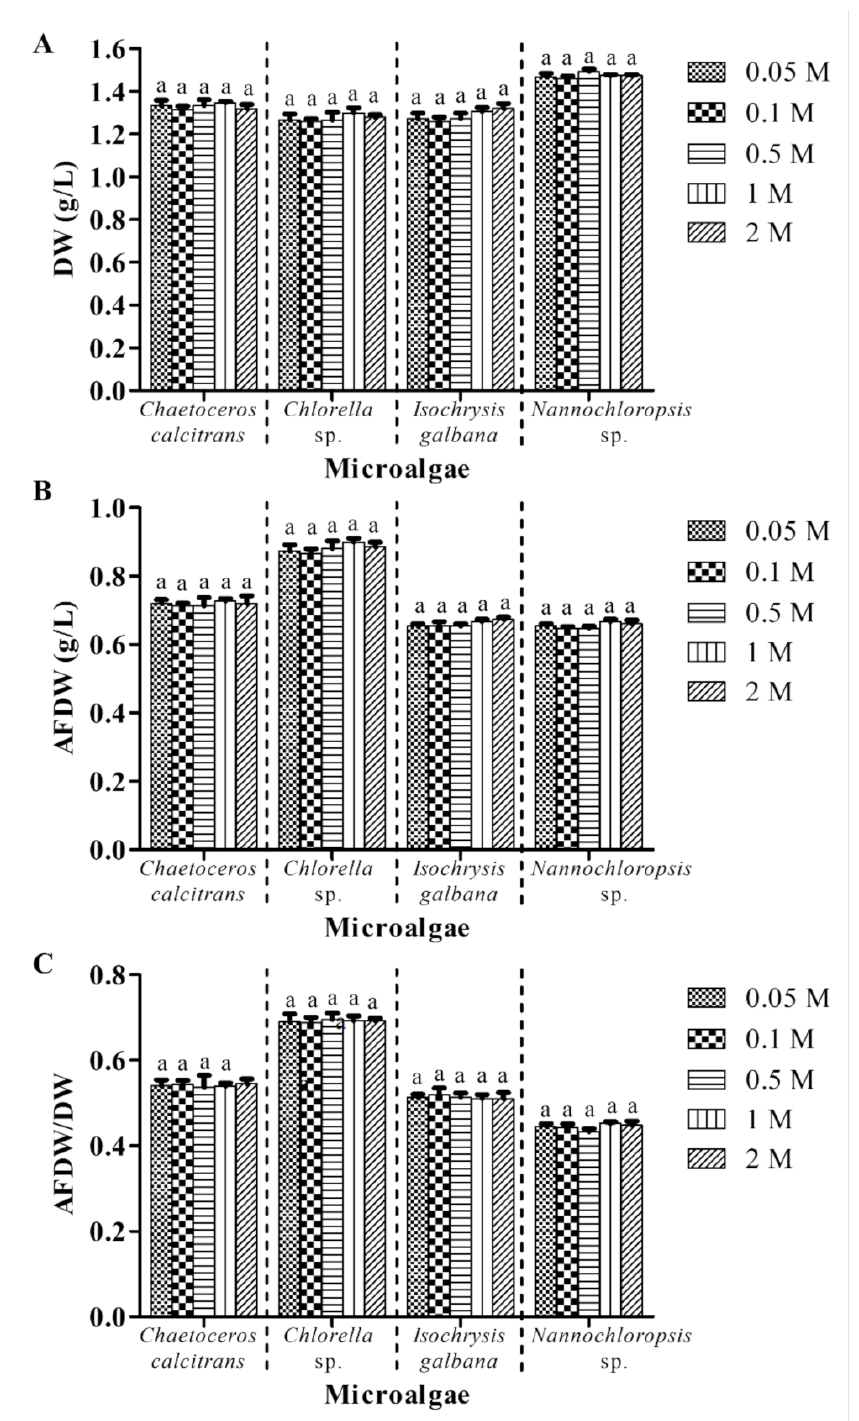
Figure 5. Biomass of four different marine microalgae subjected to different concentrations of ammonium formate. ( A ) dry weight ( B ) ash-free dry weight ( C ) ash-free dry weight/dry weight. The other parameters were the same (with washing process; GF/A; pretreatment of GMF at 450 ◦ C for 2 h; 1:1 culture: washing agent ratio; one washing cycle). Different letters for the respective microalgae indicate statistically significant differences ( p < 0.05) in terms of biomass among different concentrations of ammonium formate. DW, dry weight; AFDW, ash-free dry weight. Data are expressed as mean ± standard error (n =